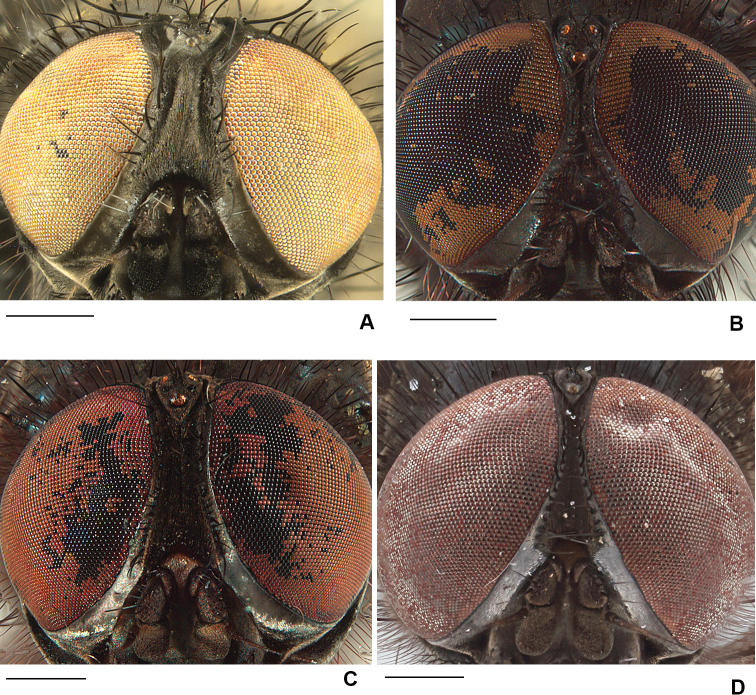
Male frons, frontal view AD.
pontiBD.
aterrimaCD.
neoborealisDD.
vockerothi. Scale bars: 0.5 mm.